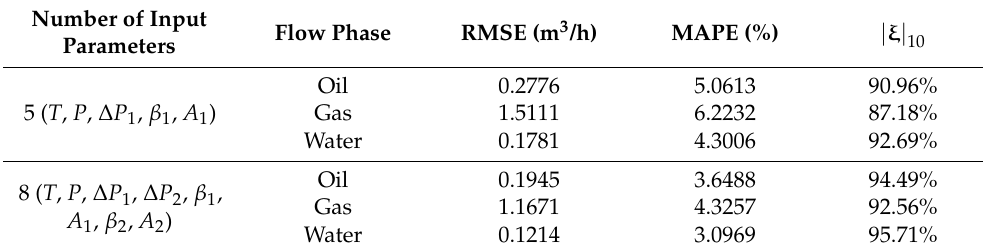
on the testing-1 dataset with different input parameters. 10